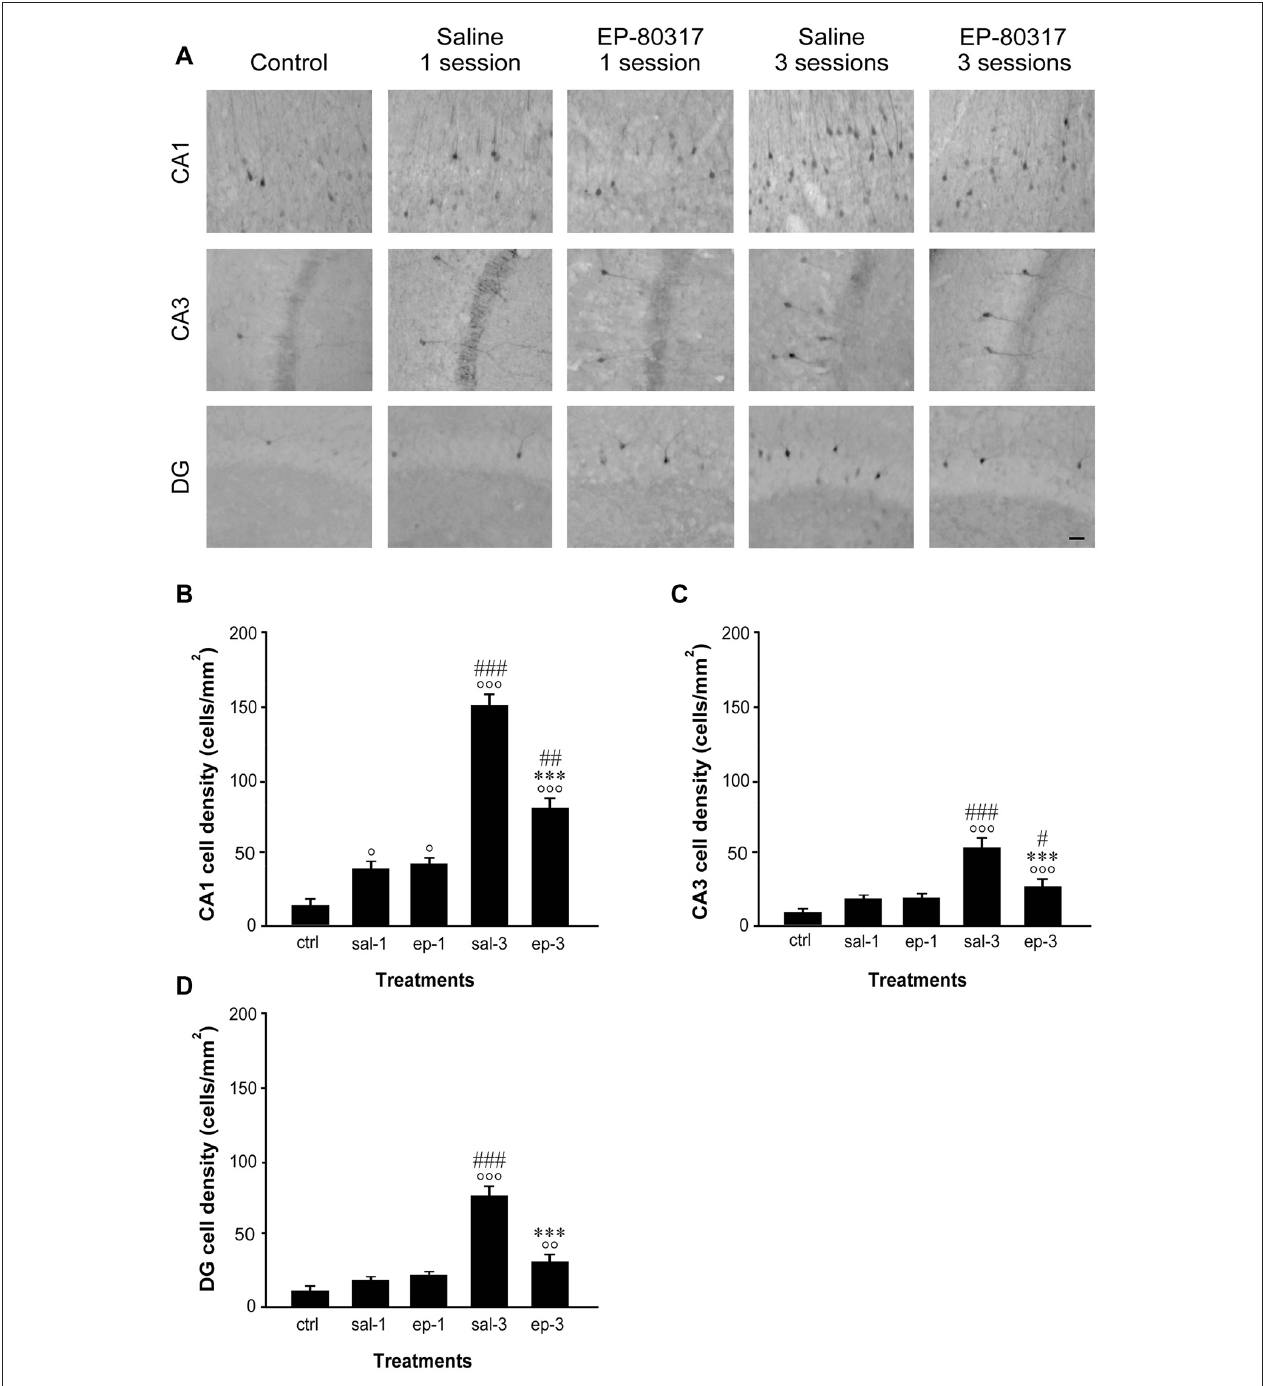
FIGURE 4 | Changes in phosphorylated extracellular signal-regulated kinases 1/2 (p-ERK1/2) immunoreactivity in hippocampal regions of mice treated with EP-80317 and exposed to different sessions of 6-Hz corneal stimulation. In (A) , p-ERK1/2 immunoreactivity is illustrated in CA1, CA3, and DG, in a representative unstimulated control (ctrl) mouse. Moreover, p-ERK1/2 immunoreactivity is also shown in mice exposed to one or three different sessions of 6-Hz corneal stimulation and pretreated with saline (sal) or EP-80317 (ep). Immunoreactivity was measured and results are illustrated in (B–D). Note that p-ERK1/2 expression was initially increased in CA1 ( ◦ P < 0.05 vs. controls; Fisher’s least significant difference test), both in EP-80317 and saline-treated mice. After the third seizure, immunopositive cells increased also in CA3 (C) and DG (D) ( ◦◦ P < 0.01, ◦◦◦ P < 0.001 vs. controls) and were higher than in the initial session ( # P < 0.05, ## P < 0.01, ### P < 0.001 vs. session 1 of the respectively considered group of treatment). However, the changes observed in mice treated with EP-80317 were less pronounced than in saline-treated mice ( ∗∗∗ P < 0.001 vs. sal-3). Scale bar, 50 µ